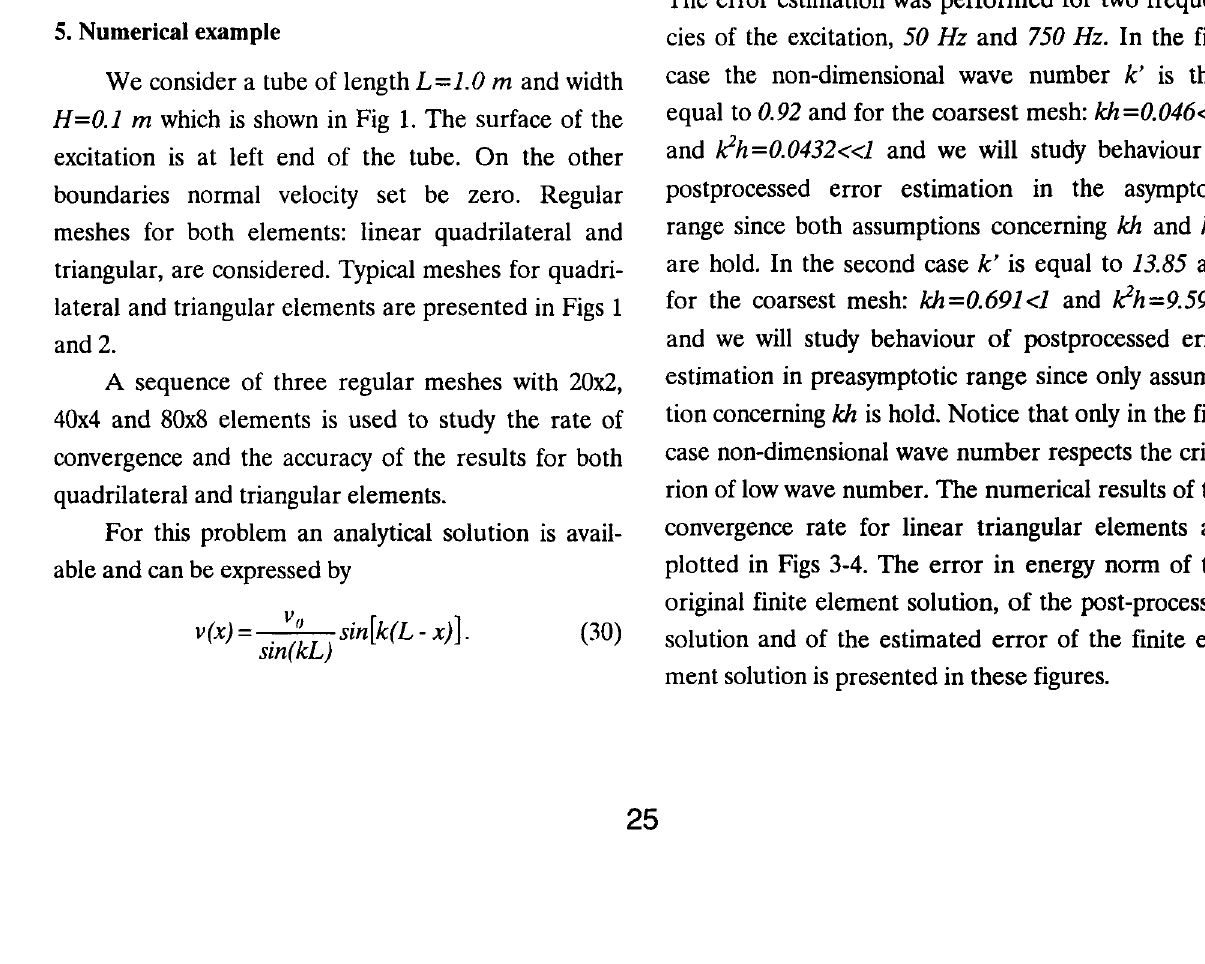
Fig 2. Typical triangular